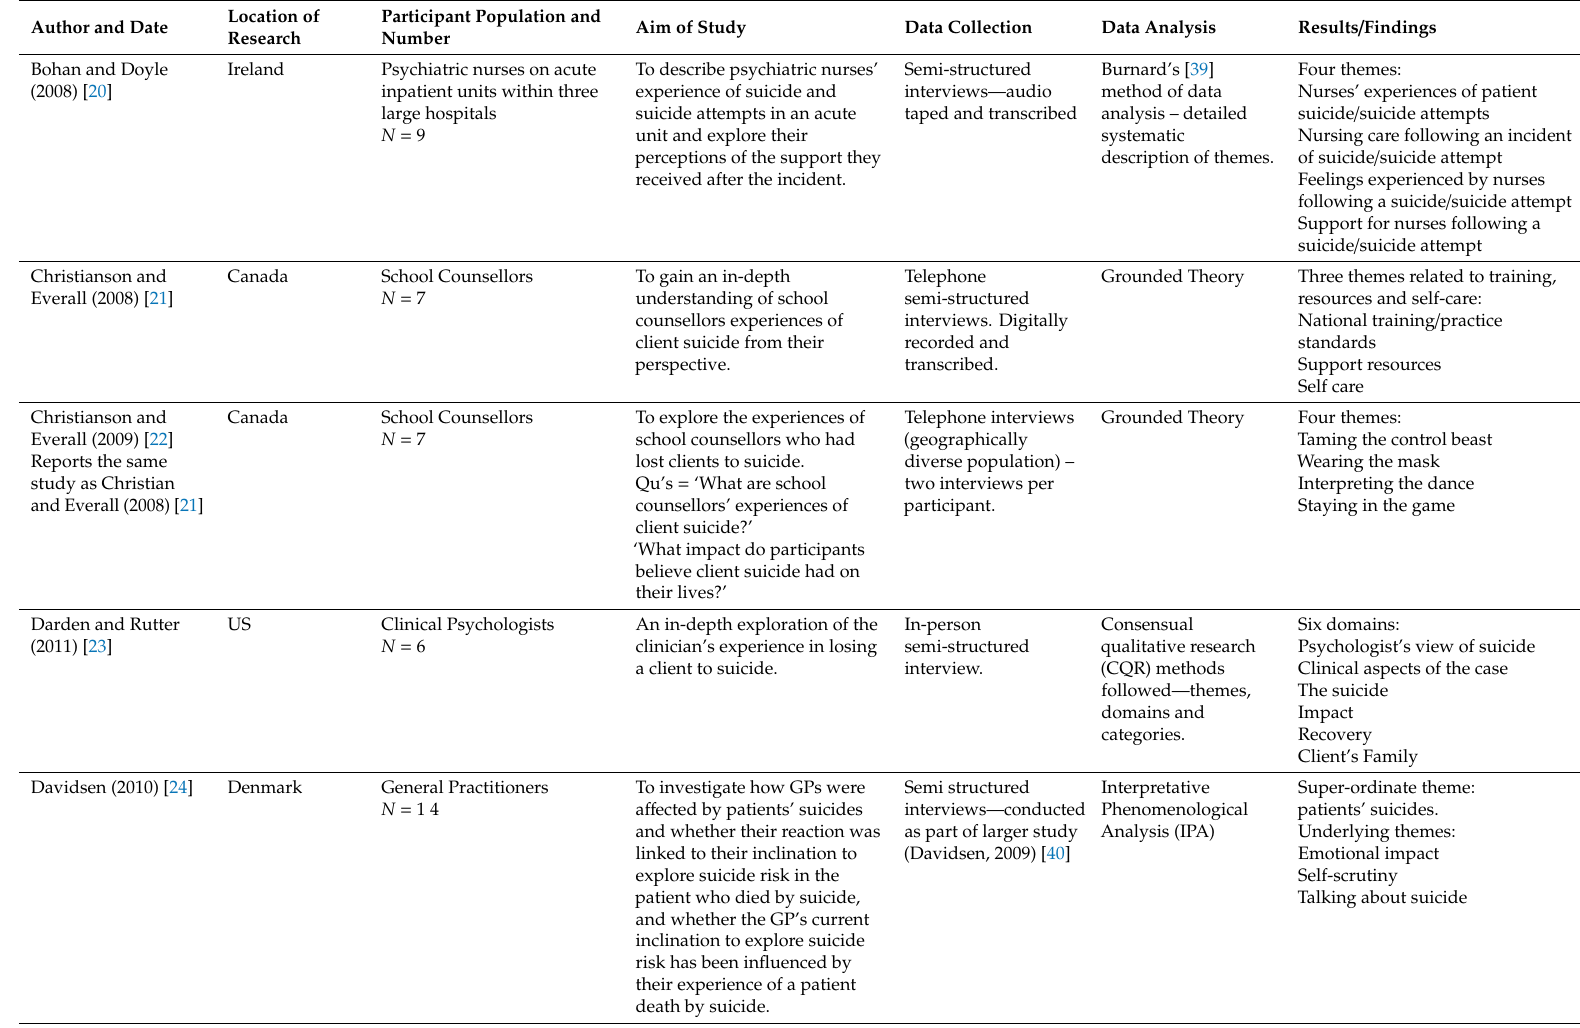
Table 1. Attributes of included